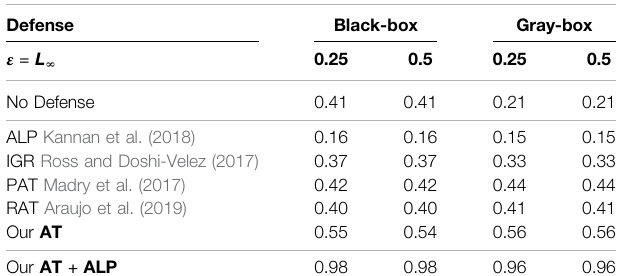
TABLE 3 | Comparing average activations on discriminate parts of 17 Flower Category Database for different defense methods. In addition, we included new statistical results of activations on part locations of 17 Flower Category Database supporting the above qualitative cases. The 17 Flower Category Database de fi ned discriminative parts of fl owers. So for each image, we got several key regions which are very important to discriminate its category. Using all testing examples of 17 Flower Category Database , we calculated normalized activations on these key regions of these different defense methods.Asshowninthistable, AT + ALP gotthehighestaverageactivations on those key regions, demonstrating that AT + ALP focused on